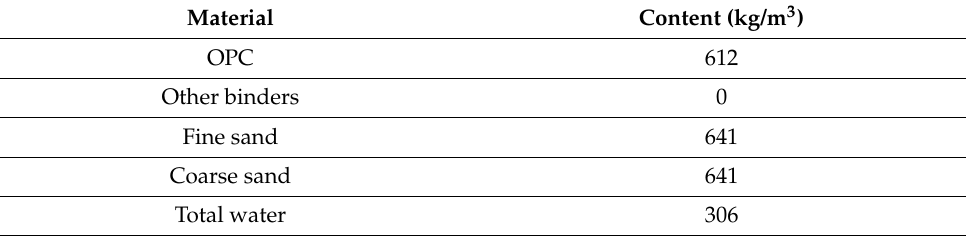
Table 3. Composition of the